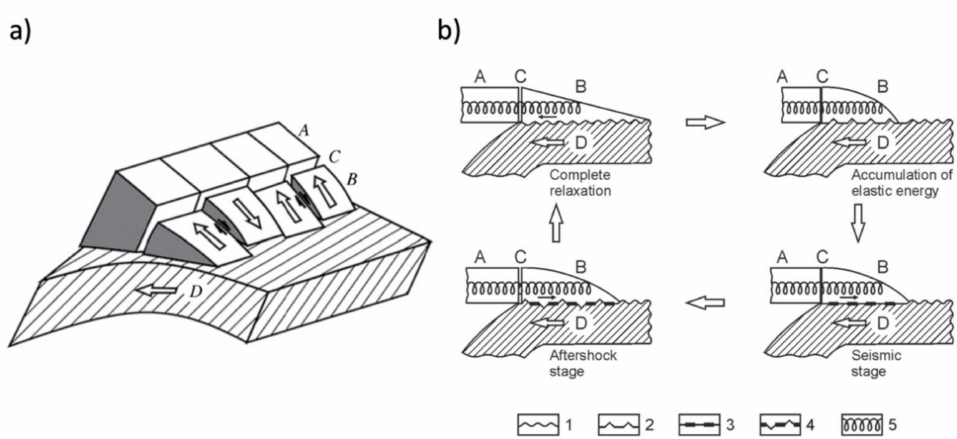
Figure 1. ( a ) Keyboard model geometry; ( b ) seismic deformation cycle phases. A is the fixed undeformable continental margin; B is the seismogenic block; C is the block-margin interface; D is the subducting plate; (1) 2-D geometry for the no deformation state; (2) stress accumulation (preseismic) phase; (3) coseismic phase (destruction of the mechanical coupling in the contact layer); (4) postseismic (aftershock) phase with continued oceanward motion of the blocks; (5) spring imitating the elastic interaction between blocks and